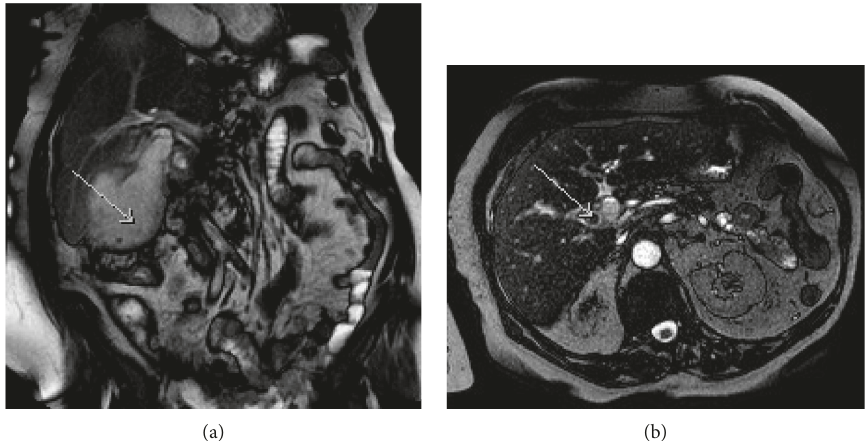
Figure 1: Coronal MRI image demonstrating large gallbladder empyema (a), and transverse MRI image section demonstrating 12mm obstructing gallstone in the cystic duct (b).